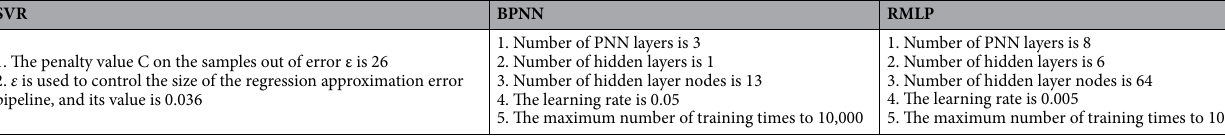
Table 5. Hyper-parameters of other